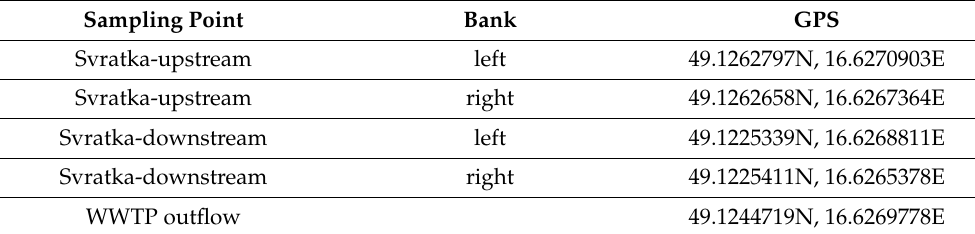
Table A1. Table of sampling points with GPS